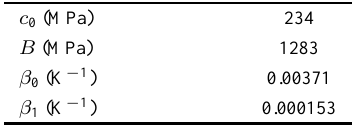
Zerilli–Armstrong parameters for 5083 Al used in numerical simulations